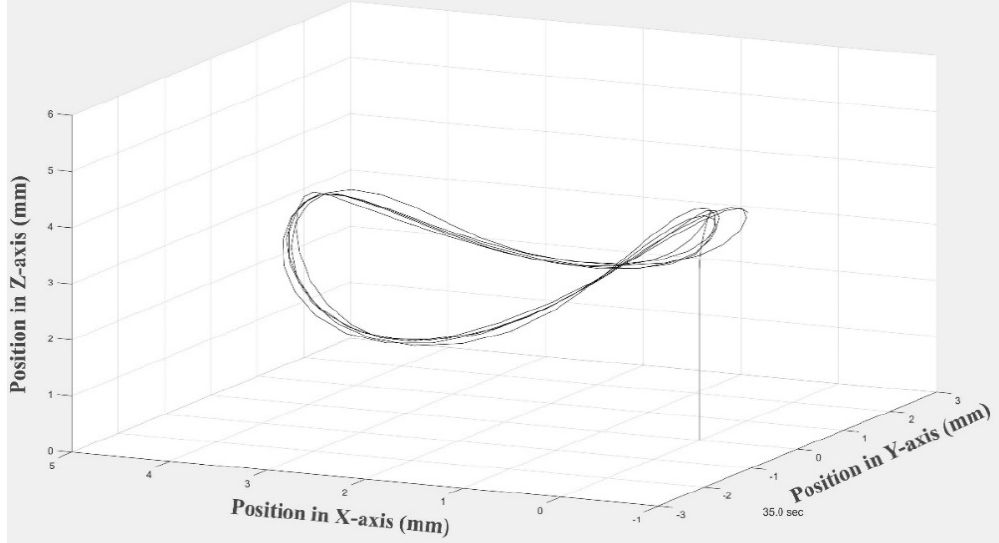
Figure 19. Motion trajectory of Marine Rescue